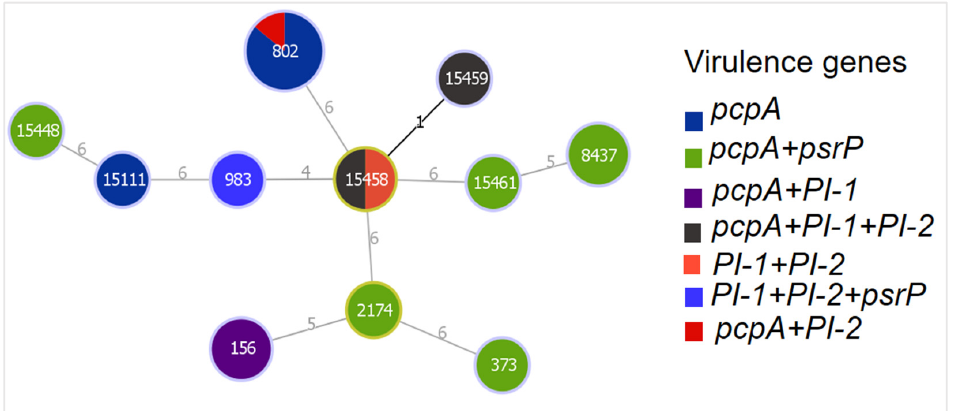
Figure 3. Distribution of virulence genes among STs of MDR strains. Colors show the presence of different virulence genes. Diameters of the nodes are proportional to the number of isolates. Founder STs have a yellow color around their nodes. Branch labels correspond to the number of allelic variations between STs; branch lengths are not to scale.